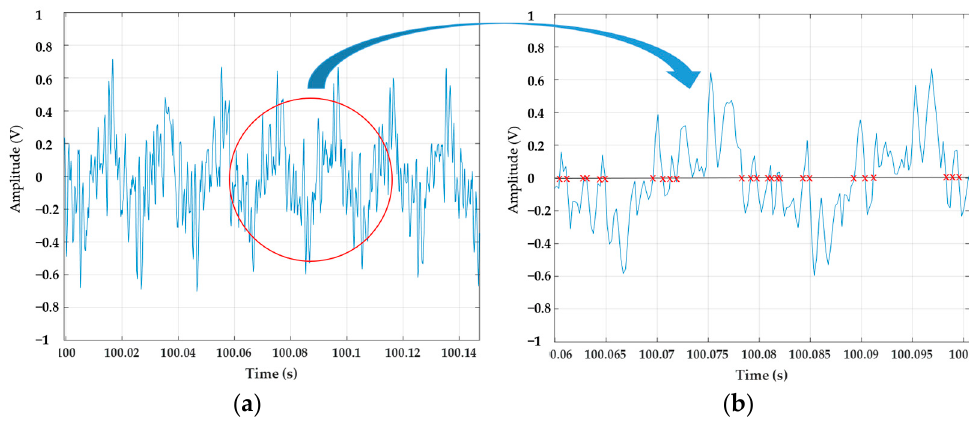
Figure 6. ( a ) Multiple zero − crossings of the time signal; ( b ) Detail.